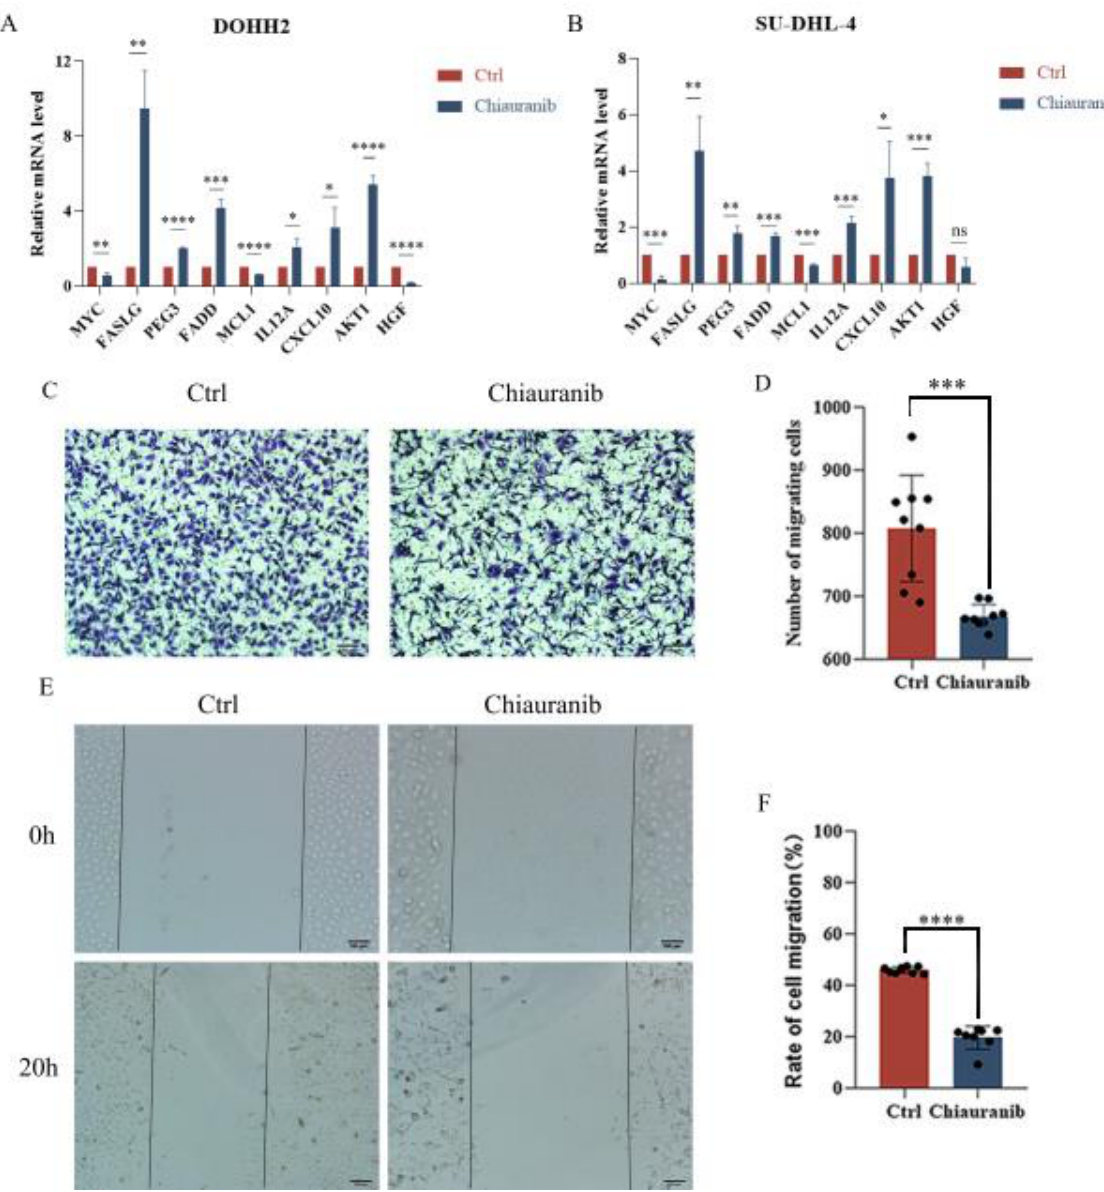
Figure 5. Chiauranib alters gene expression levels downstream of STAT3. Chiauranib (20 µM) inhibited the mRNA levels of downstream genes of STAT3, of ( A ) DOHH2, and ( B ) SU-DHL4 cells treated with chiauranib. ( C , D ) Transwell assay and ( E , F ) wound healing test to validate the migration of HUVECs following drug treatment (5 µM chiauranib; proportional scale 1:100 µm). (* p < 0.05;** p < 0.01;*** p < 0.001;**** p < 0.0001).